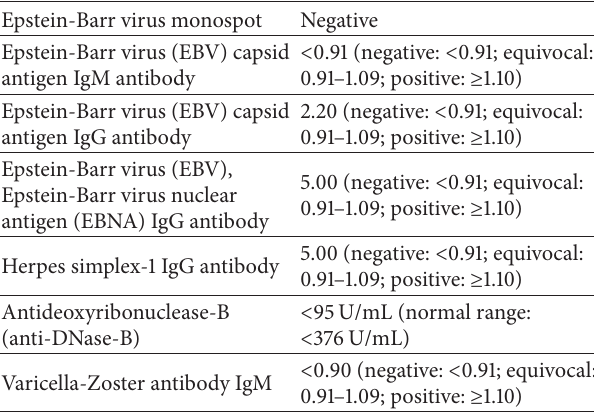
Epstein-Barr virus